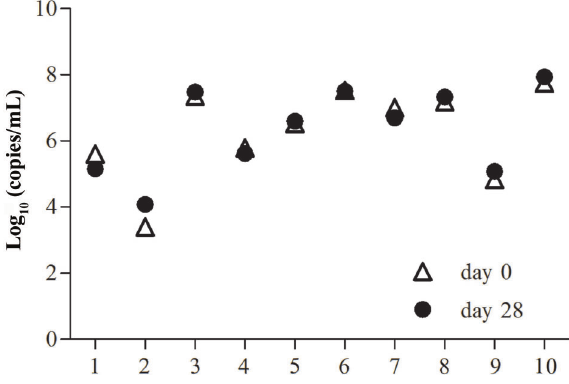
Figure 3. Comparison of Neisseria gonorrhoeae DNA concentra- tions using extracted DNA at day 0 and at day 28 of storage at